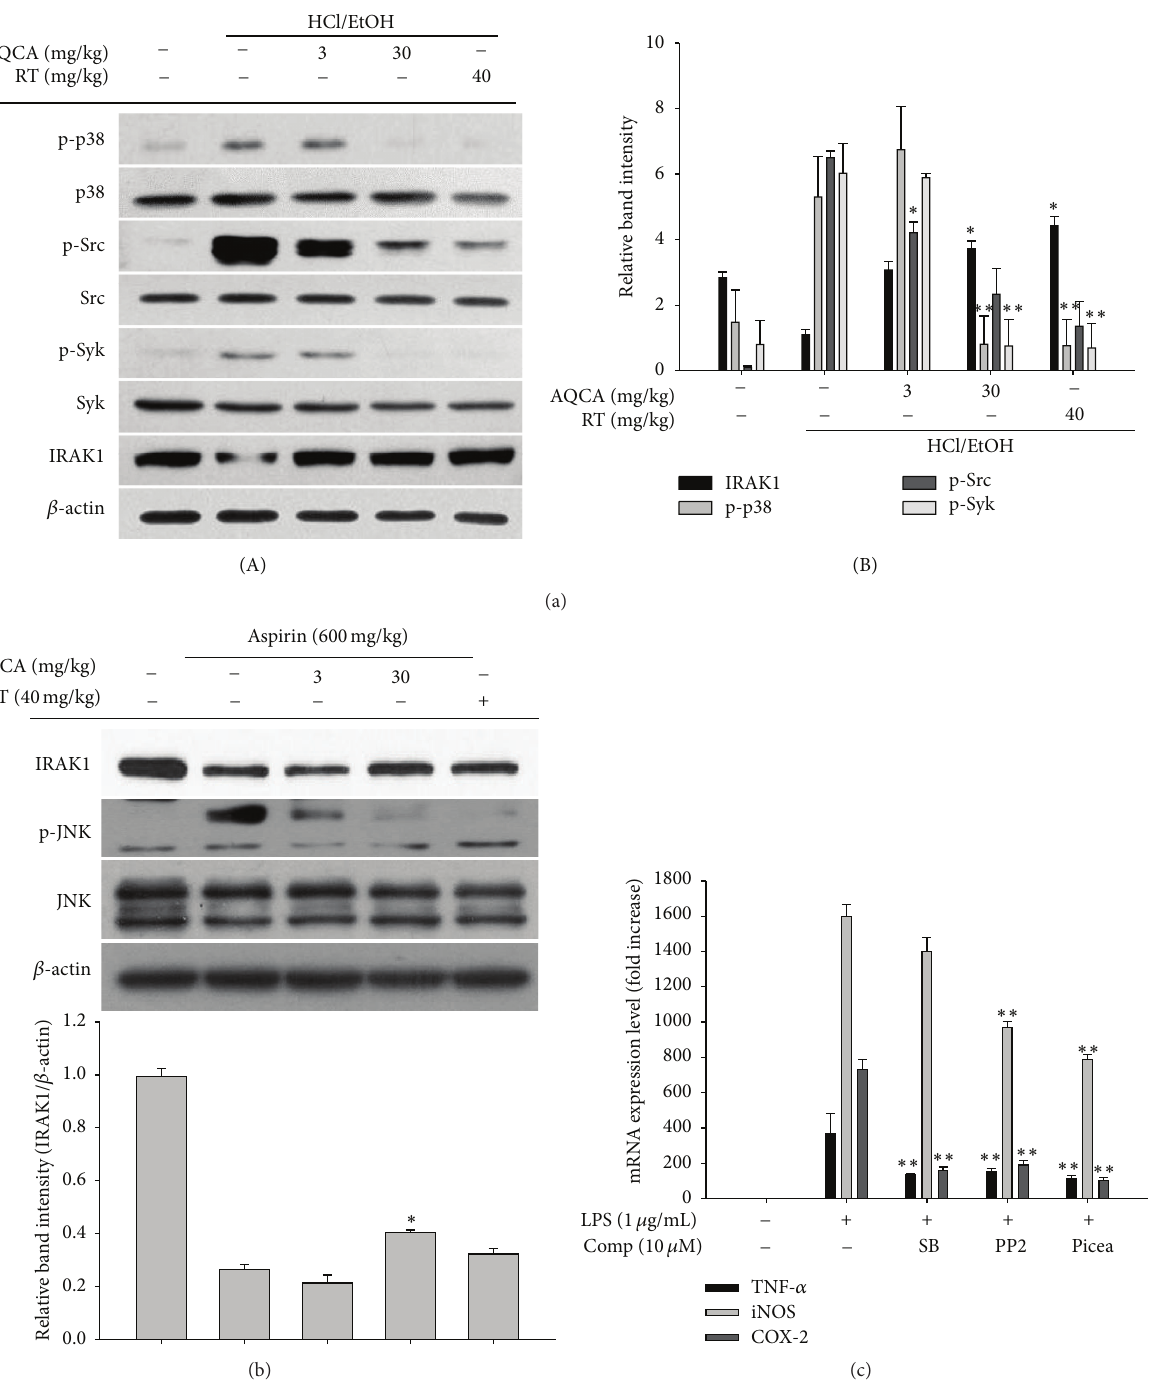
(B)p-p38 Figure 5: Effect of AQCA on the activation of signaling enzymes. (a and b) Total lysates were prepared from stomach tissues of mice treated with HCl/EtOH or aspirin that had been orally treated with AQCA (0, 3, and 30mg/kg) or RT (ranitidine, 40mg/kg). The total and phosphoforms of p38, JNK, Src, Syk, and IRAK1 were analyzed by immunoblotting analysis. (c) mRNA levels of inflammatory genes (iNOS, TNF- 𝛼 , and COX-2) in LPS-treated RAW264.7 cells pretreated with SB203580 (SB), PP2, or piceatannol (Picea) were determined by real-time RT-PCR. Relative intensity was calculated using 𝛽 -actin level and the DNR Bio-Imaging System ((a)(B) and (b) bottom panels). ∗ 𝑃 < 0.05 and ∗∗ 𝑃 < 0.01 compared with the control